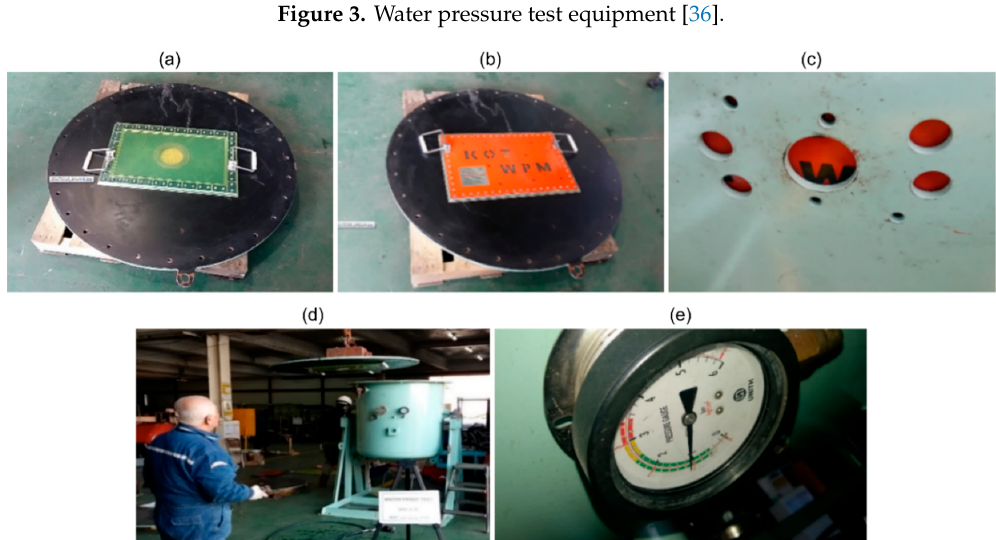
Figure 4. Water pressure tests (maximum pressure: 1.0 kg/cm 2 ). Clockwise from top left: ( a ) 120 mm hole steel plate; ( b ) attached condition of steel plate with 80 mm, 40 mm, and 20 mm diameter hole, ( c ) opposite side teel plate 80 mm, 40 mm, and 20 mm diameter hole; ( d ) test equipment assembly; ( e ) application of maximum pressure.